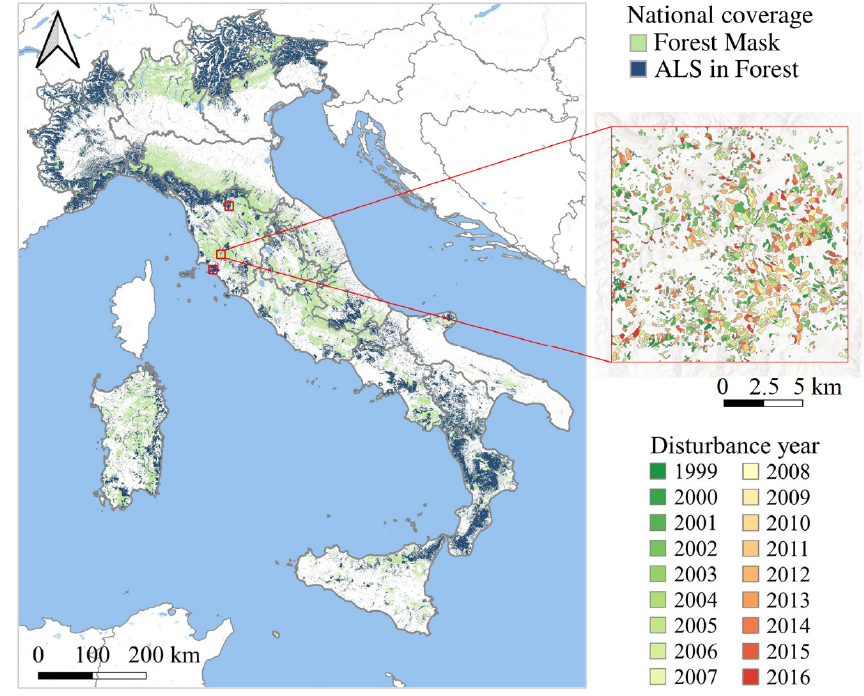
Figure 1. Study area, forest harvestings reference dataset (red boxes), and ALS data